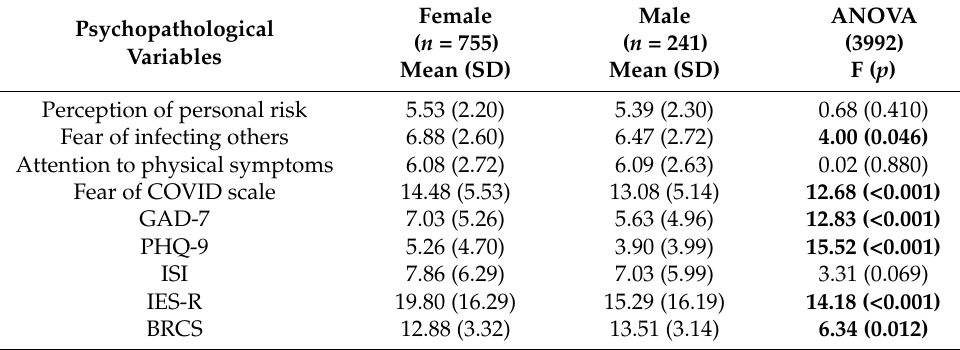
Table 3. Psychopathological scores in healthcare workers by